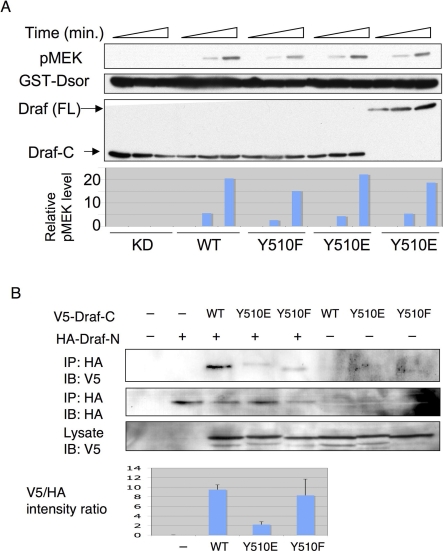
Y510E Substitution Interferes with Draf Autoinhibitory Interaction(A) V5-tagged Draf-CKD (K497M; kinase-dead), Draf-CWT, Draf-CY510F, Draf-CY510E, and the full-length DrafY510E (FL) were transfected into S2 cells and immunoprecipitated by anti-V5. The immunoprecipitates were subjected to kinase assay using bacterially expressed Dsor1 as substrate for 0, 5, or 30 min, respectively. The kinase activity was measured by anti-pMEK signals and plotted at the bottom. Note that all Draf-C variants and the full-length DrafY510E exhibited similar kinetics and activities. WT, wild type.(B) V5-tagged Draf-CWT, Draf-CY510F, or Draf-CY510E was cotransfected with or without HA-Draf-N (HA) into S2 cells, and the cells were subjected to immunoprecipitation (IP) by anti-HA and then SDS-PAGE. Quantifications of three independent western blots (IB) are shown in the bottom. Intensity of gel bands of anti-V5 (first row) versus anti-HA (second row) are shown for each Draf-C. Note that compared with Draf-CWT (lane 3), much less Draf-CY510E (lane 4) was coimmunoprecipitated with Draf-N.